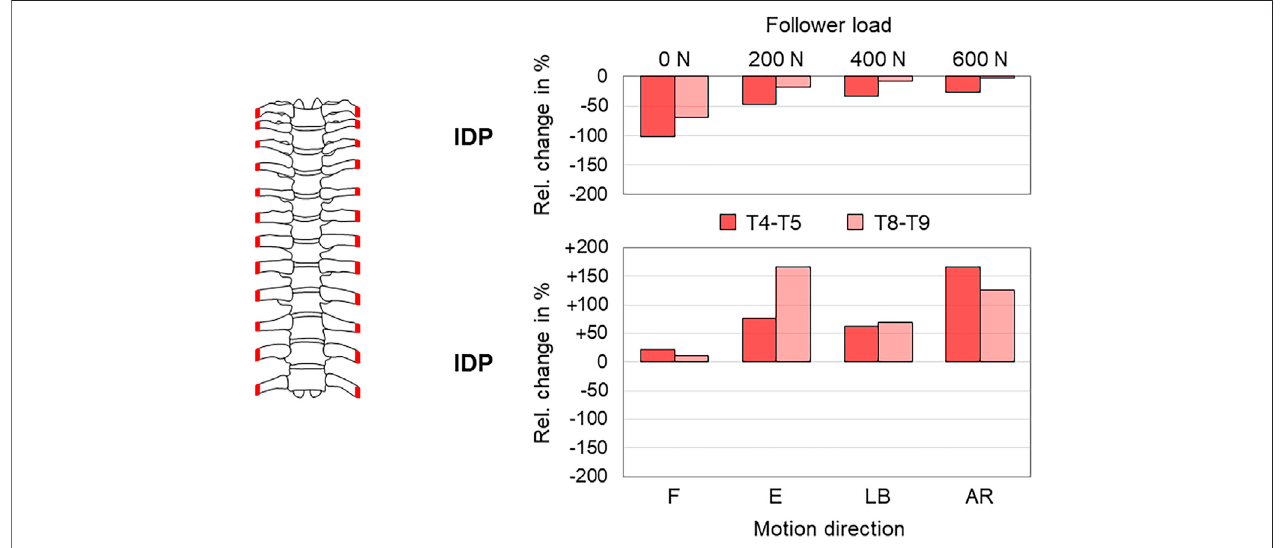
FIGURE 11 | Anterior rib cage removal. The relative intradiscal pressure (IDP) changes of the thoracic spine (T4 – T5 and T8 – T9) after anterior rib cage removal with pure follower loads according to Anderson et al. (2016) and with a follower load of 400 N during fl exion (F), extension (E), lateral bending (LB), and axial rotation (AR) according to Anderson et al. (2018).